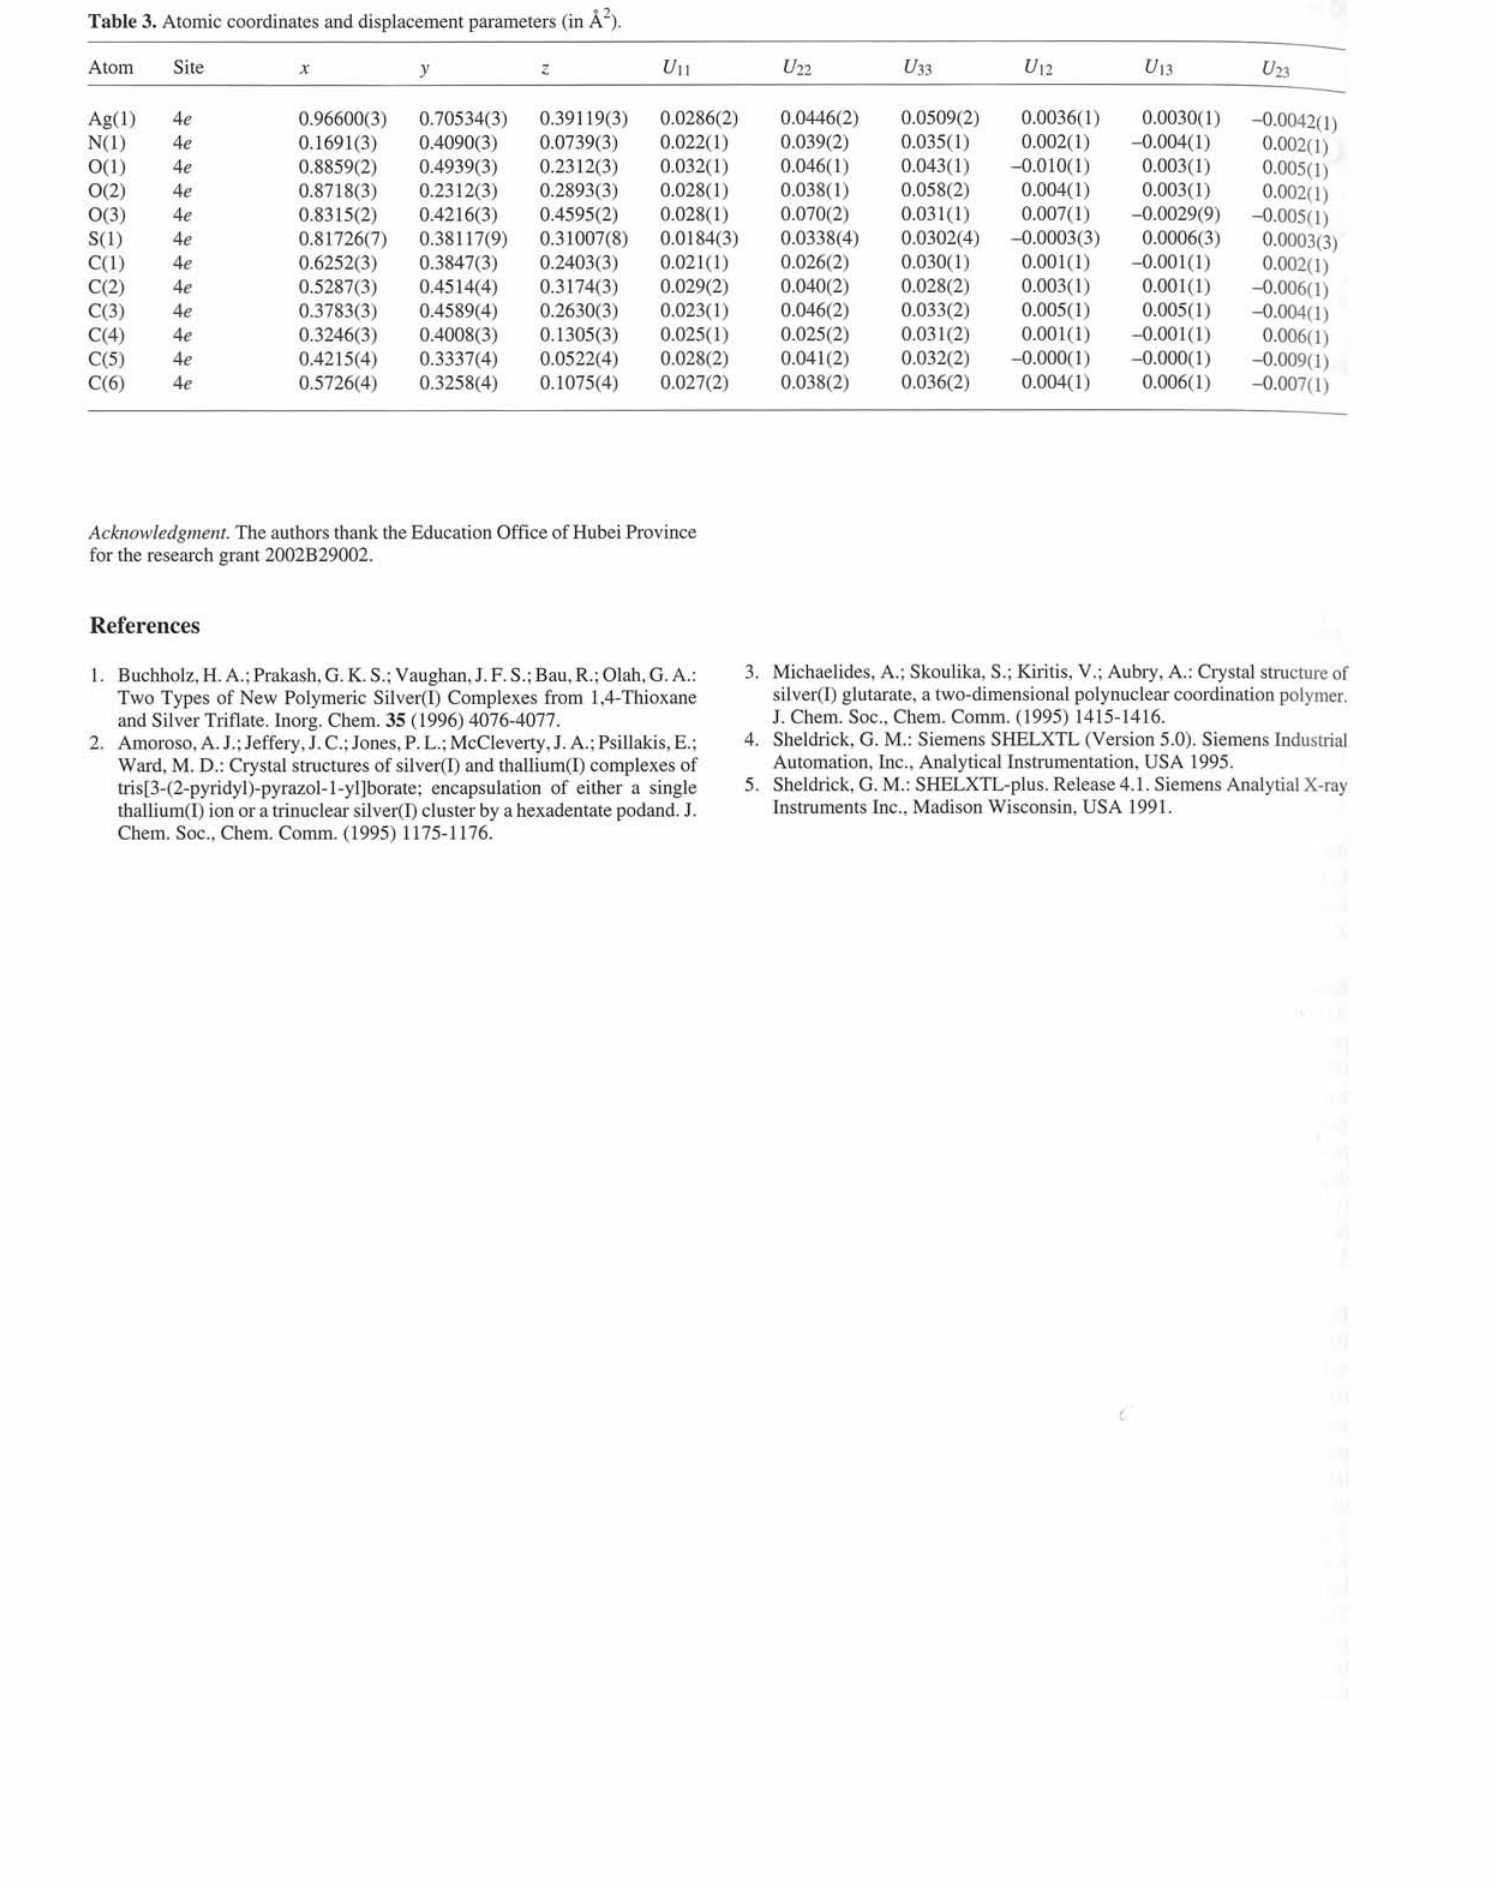
Table 3. Atomic coordinates and displacement parameters (in Â 2